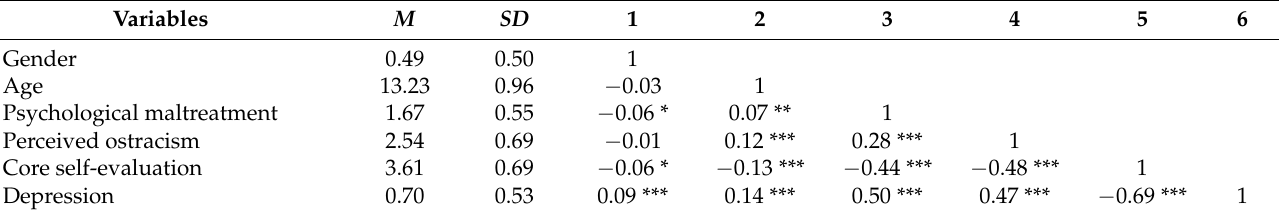
Table 1. Descriptive statistics and correlations among